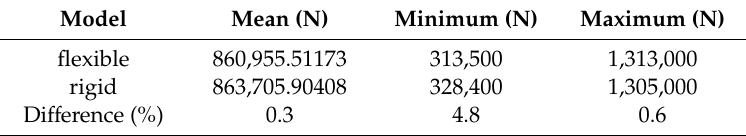
Table 7. Comparison of statistical data (taut mooring line, average wind speed of 24 m/s).